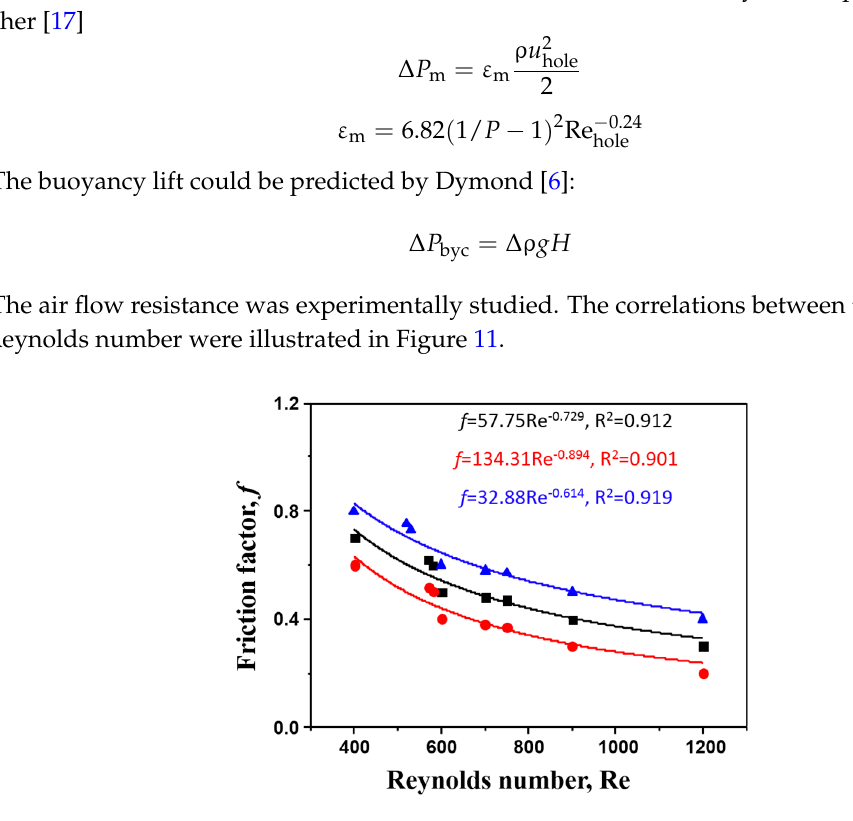
Figure 11. Friction factor plotted against Reynolds number of the three collectors.